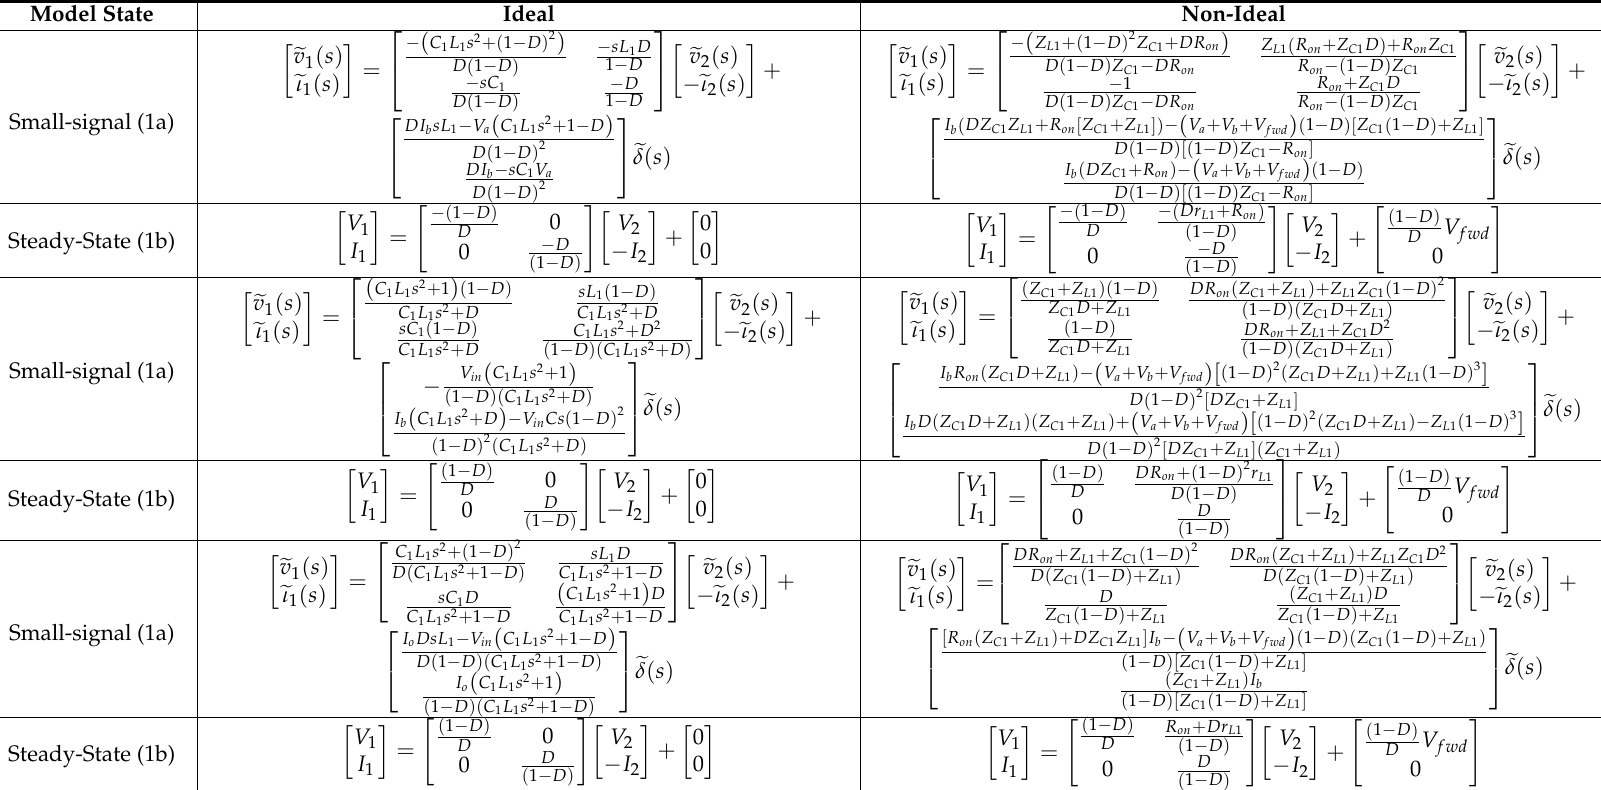
Table 3. Small-signal and steady-state models for the lumped Type 2